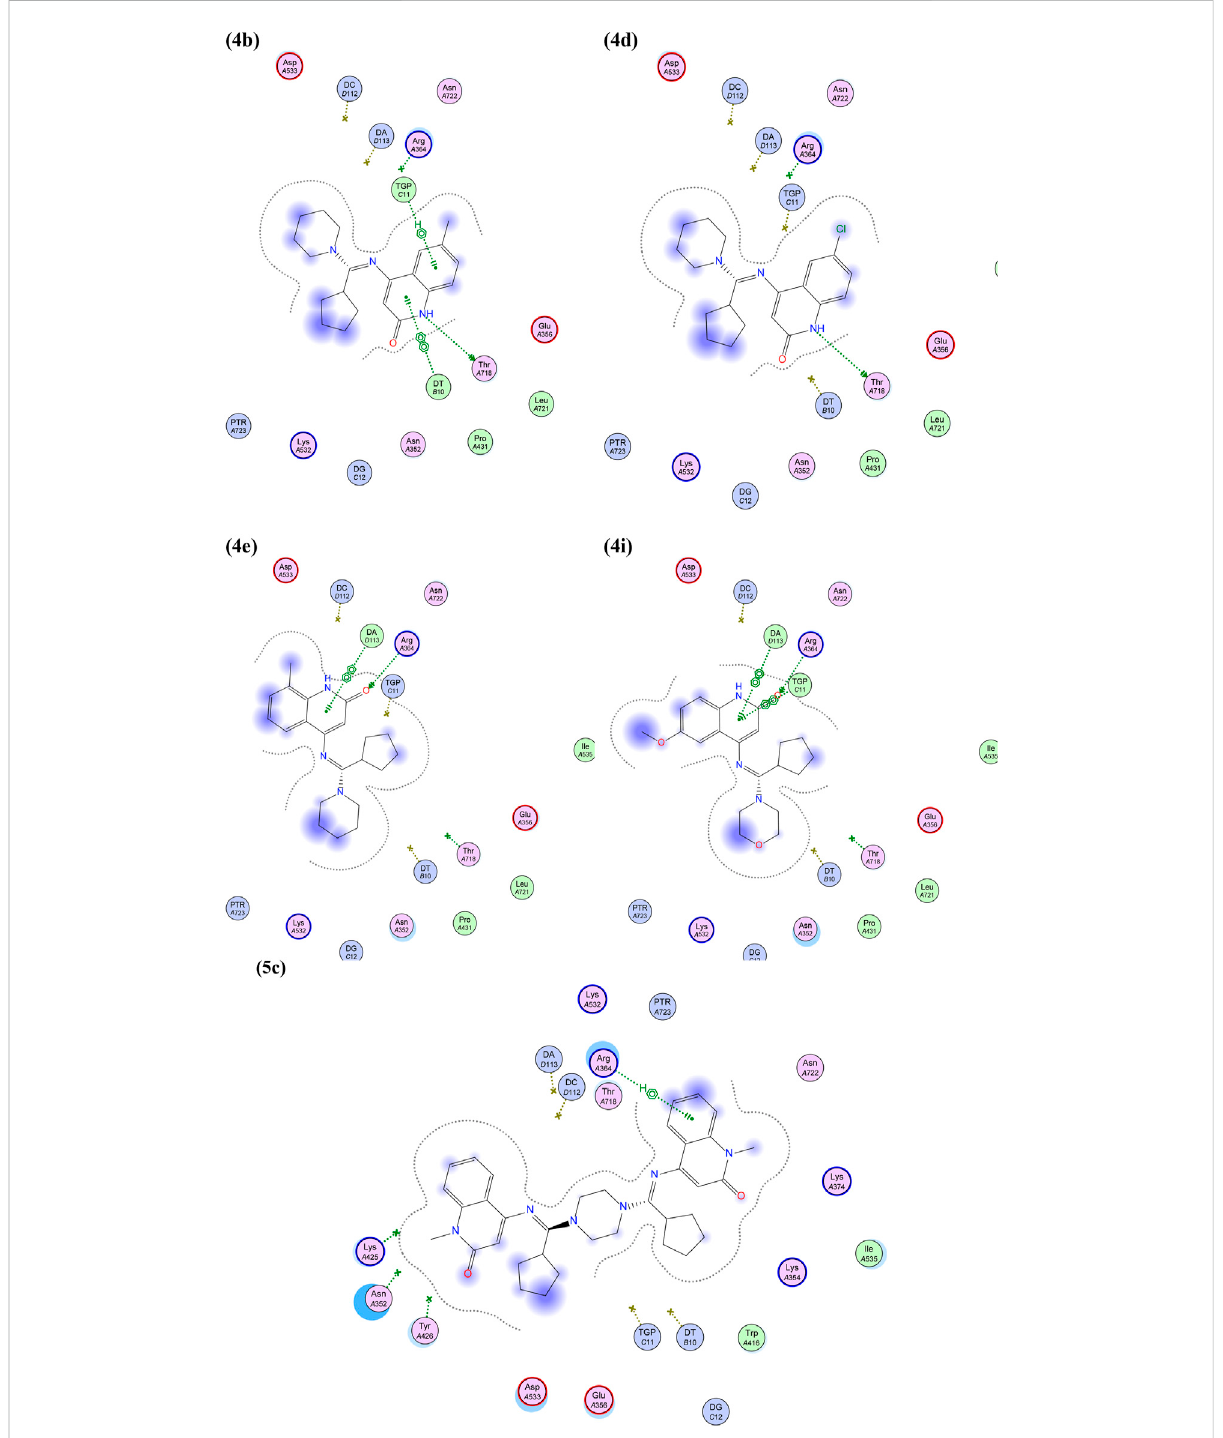
FIGURE 6 Best poses of 4b, 4d, 4e, 4i, and 5c into the DNA-Topo I complex, showing H-bonds (as a green arrow) and both pi-H and pi-pi stacking interactions (as green-dotted